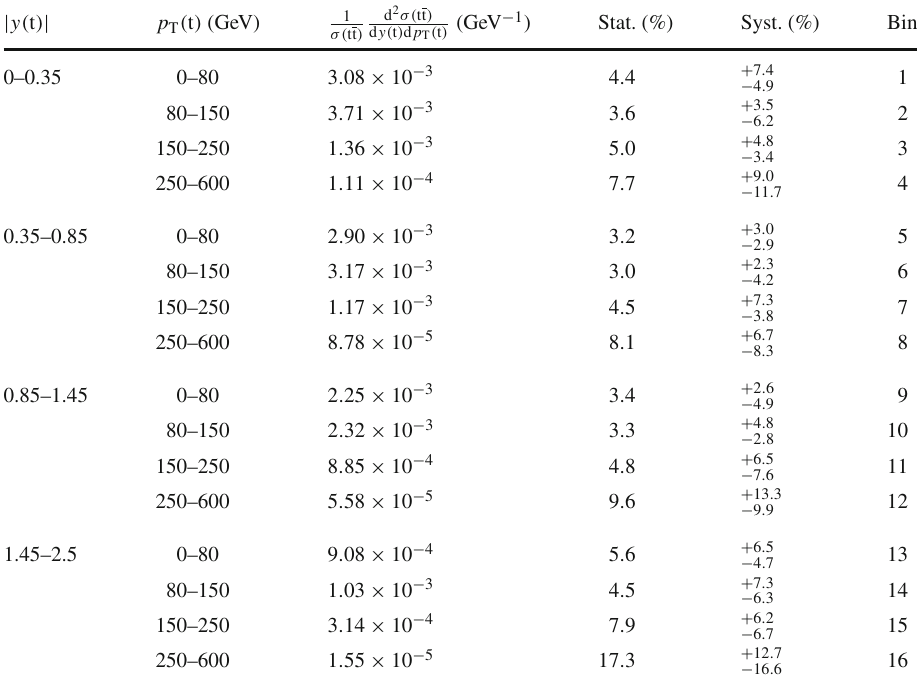
Table 5 The measured normalized tt double-differential cross sections in different bins of y ( t ) and p T ( t ) , along with their relative statistical and systematic uncertainties